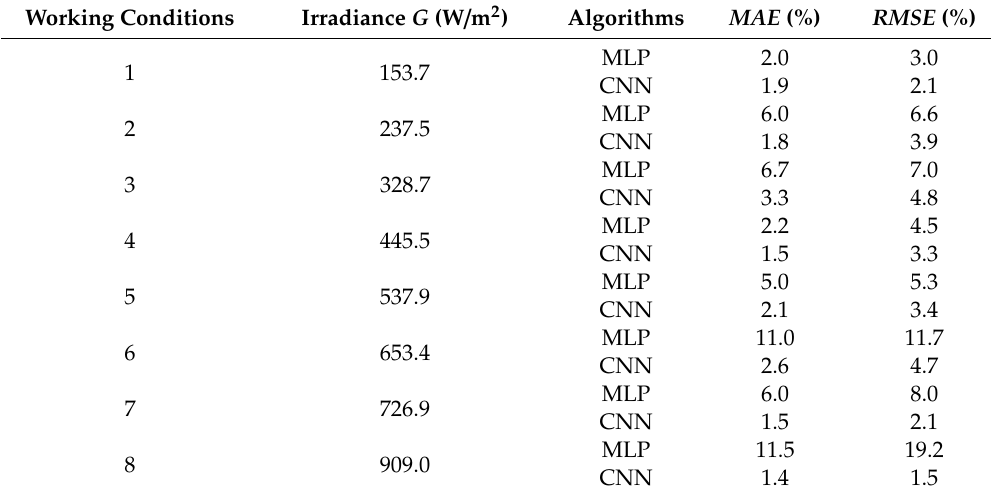
Table 2. RMSE and MAE of I–V